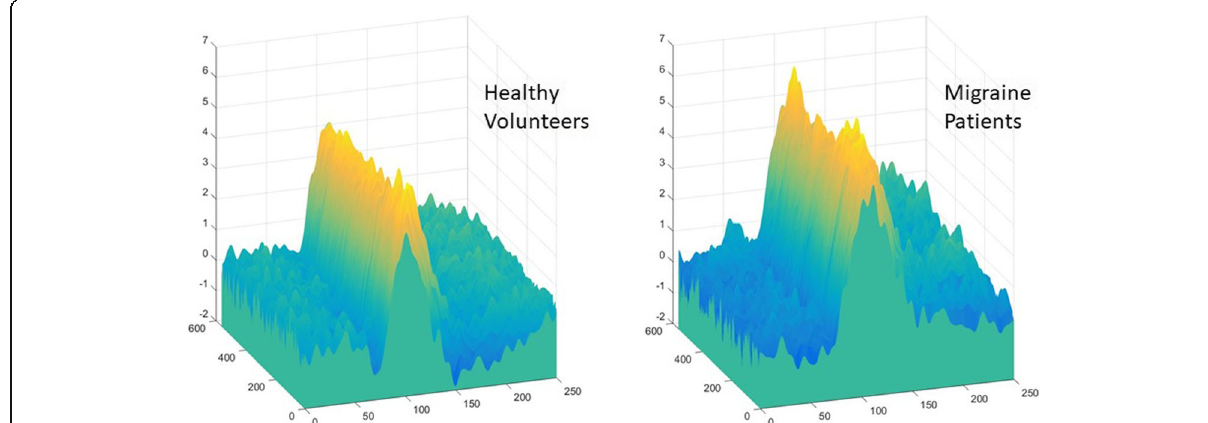
Fig. 1 Mean Visual Evoked potentials (x = time in ms, y = trial number, z = amplitude in μ V) in healthy volunteers (left) and episodic migraine patients (right). The area under the curve was calculated with respect to the baseline